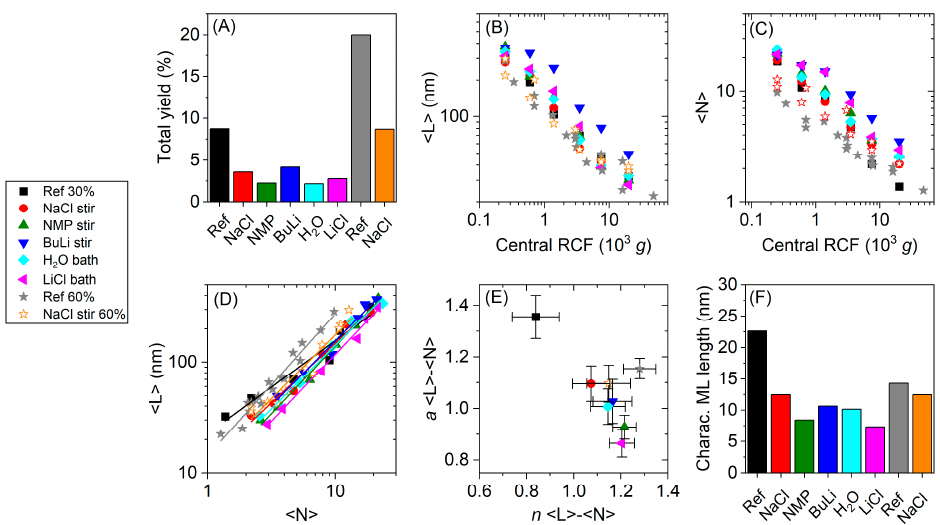
Figure 3. Yield and size information of LPE WS 2 nanosheets, derived from the optical extinction spectra in Figures A1 and A2. The bulk WS 2 powders were subjected to different pretreatments prior to exfoliation and the exfoliated stock dispersions were size selected by liquid-cascade centrifugation. ( A ) Total yield of the different batches. The total yield is the sum of the individual yields of each fraction obtained during the size selection process, excluding the sediment of the first centrifugation step, which was discarded. The yield of the pretreated materials is lower than the references. ( B ) Mean nanosheet length, <L>, as a function of central RCF. ( C ) Mean nanosheet layer number, <N> as a function of central RCF. ( D ) <L> as a function of <N>, fitted by power laws. ( E ) Prefactor and exponents extracted from the power law fits in ( D ). Pretreated materials group together while Ref 30% exhibits a higher prefactor and lower exponent. ( F ) Characteristic ML length of the different batches. Highest ML length was found for Ref 30%.